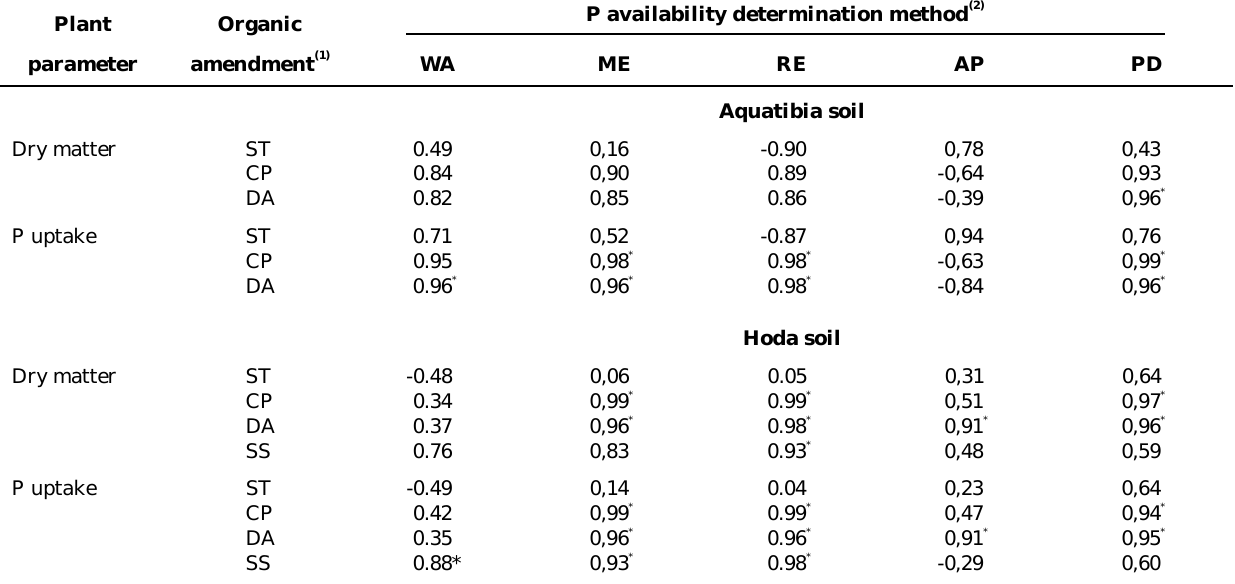
Table 5. Linear correlation coefficients between P availability measured by different methods versus dry matter from tops of corn plants and P uptake by the